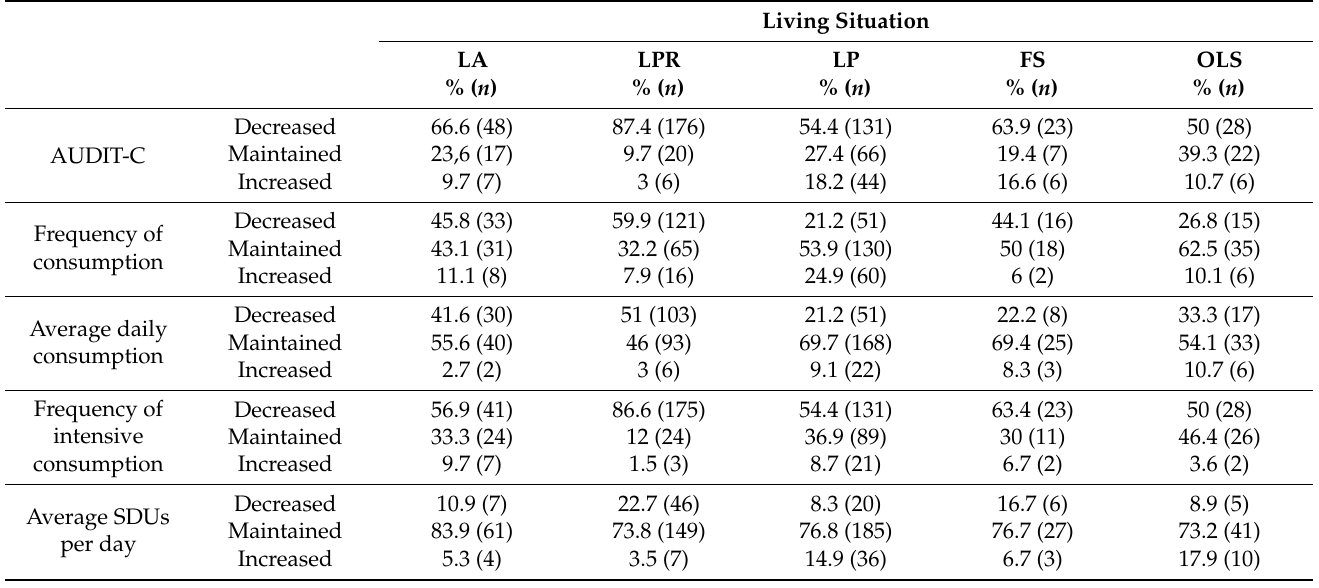
Table 5. Changes in alcohol consumption according to the living situation during confinement in risky consumers ( n =